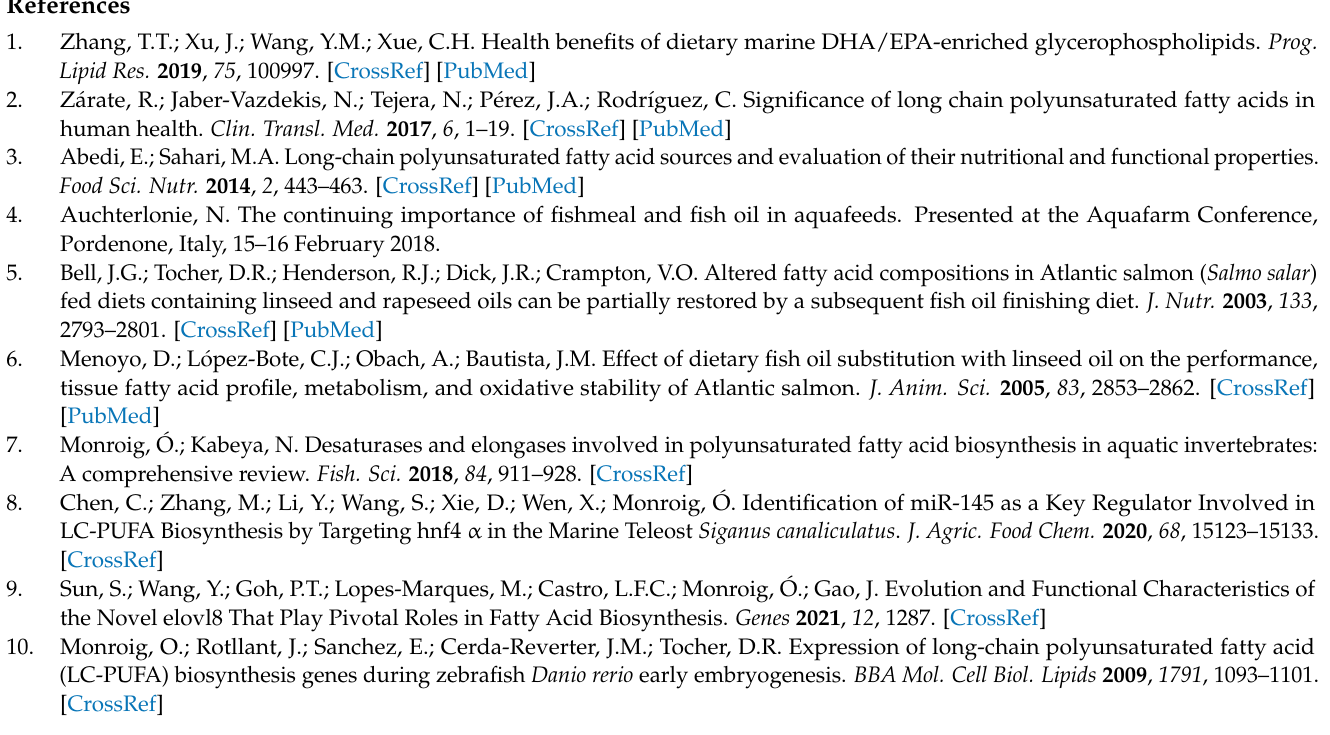
putative membrane-spanning domains are underlined; the ER retrieval signal is wavy underlined, Figure S6: Nucleotide and deduced amino acid sequence of Fads2 in hybrid grouper (GenBank accession number MZ713366). The nucleotide sequence is numbered from the first base at the 5 (cid:48) end, started in codon (ATG) and stopped in codon (TGA). The Cytochrome b5-like Heme/Steroid binding domain is in gray; the putative histidine-rich domain (HXXHH, HDXGH and QXXHH) is in bold; the predicted four (I-IV)